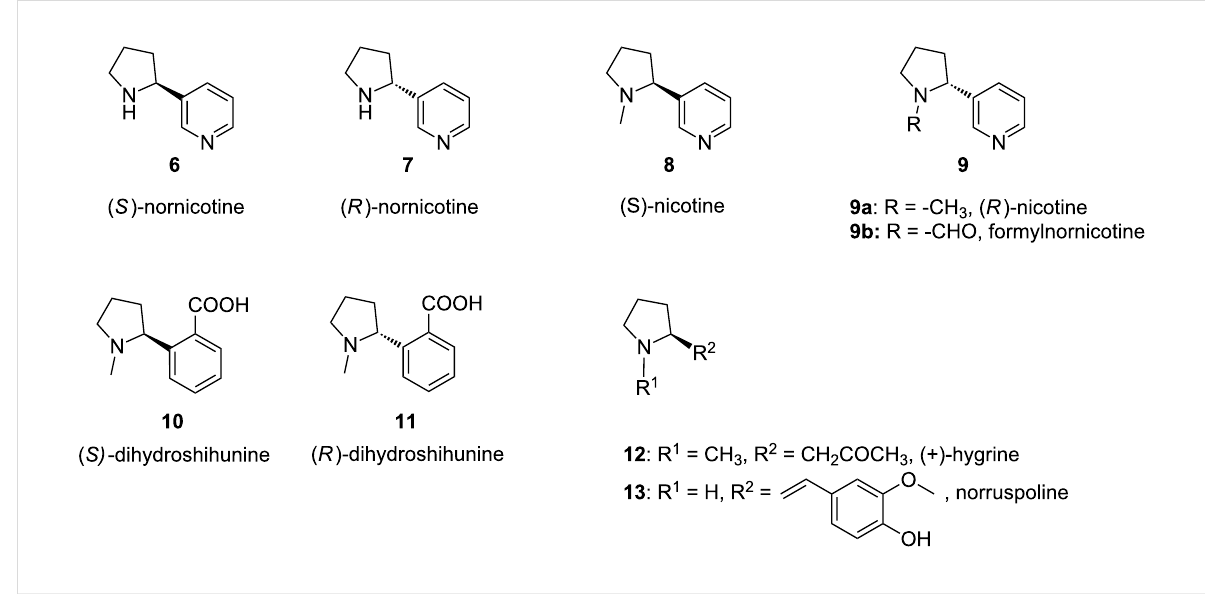
Figure 2: Natural products containing 2-substituted pyrrolidine residues in their core structural units.